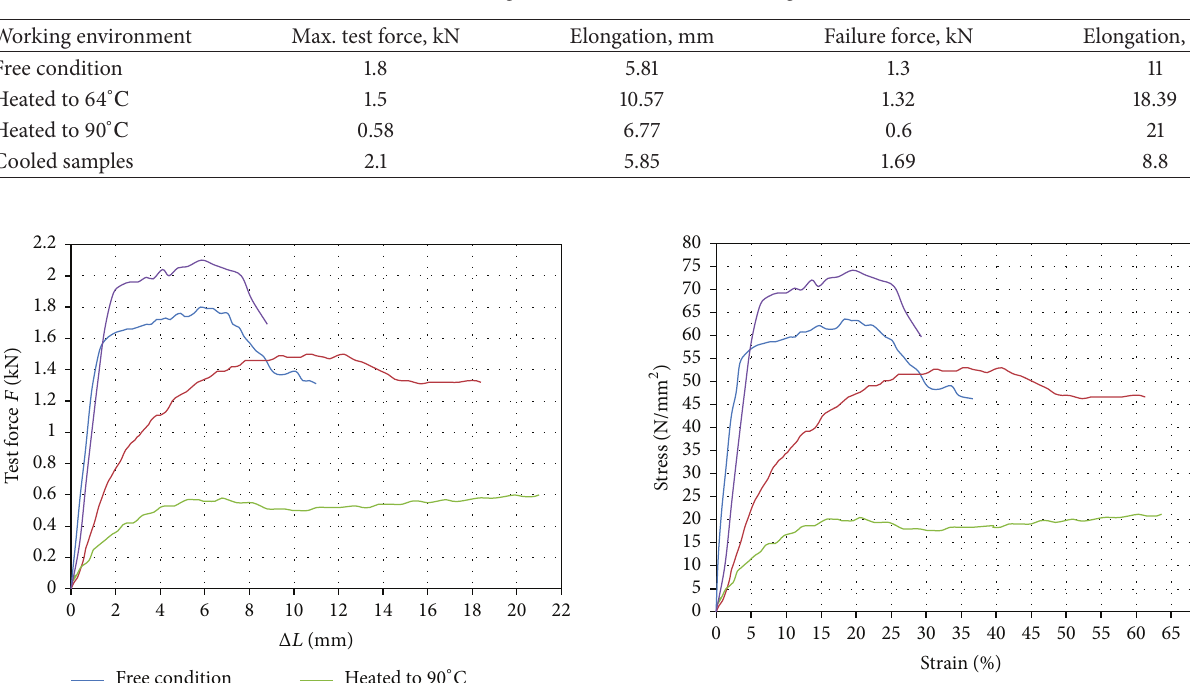
Table 2: Force and elongation data for different working environments.